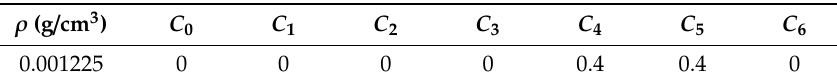
Table 3. Air parameters.